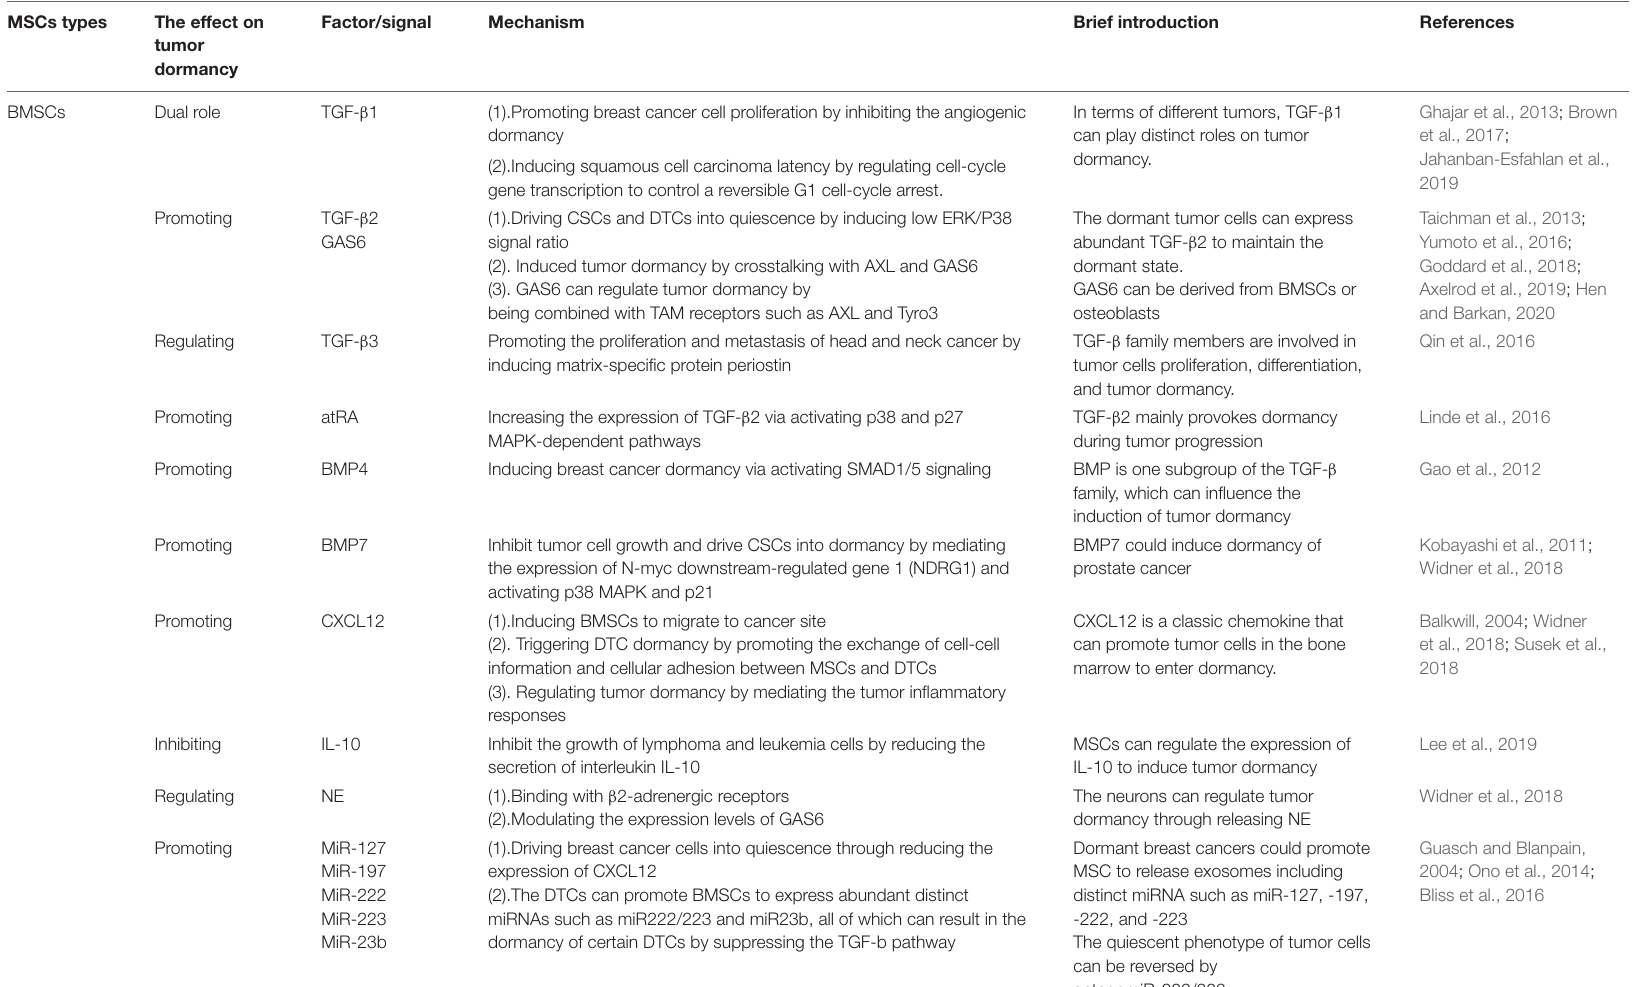
TABLE 1 | The effect of MSCs on tumor dormancy. MSCs